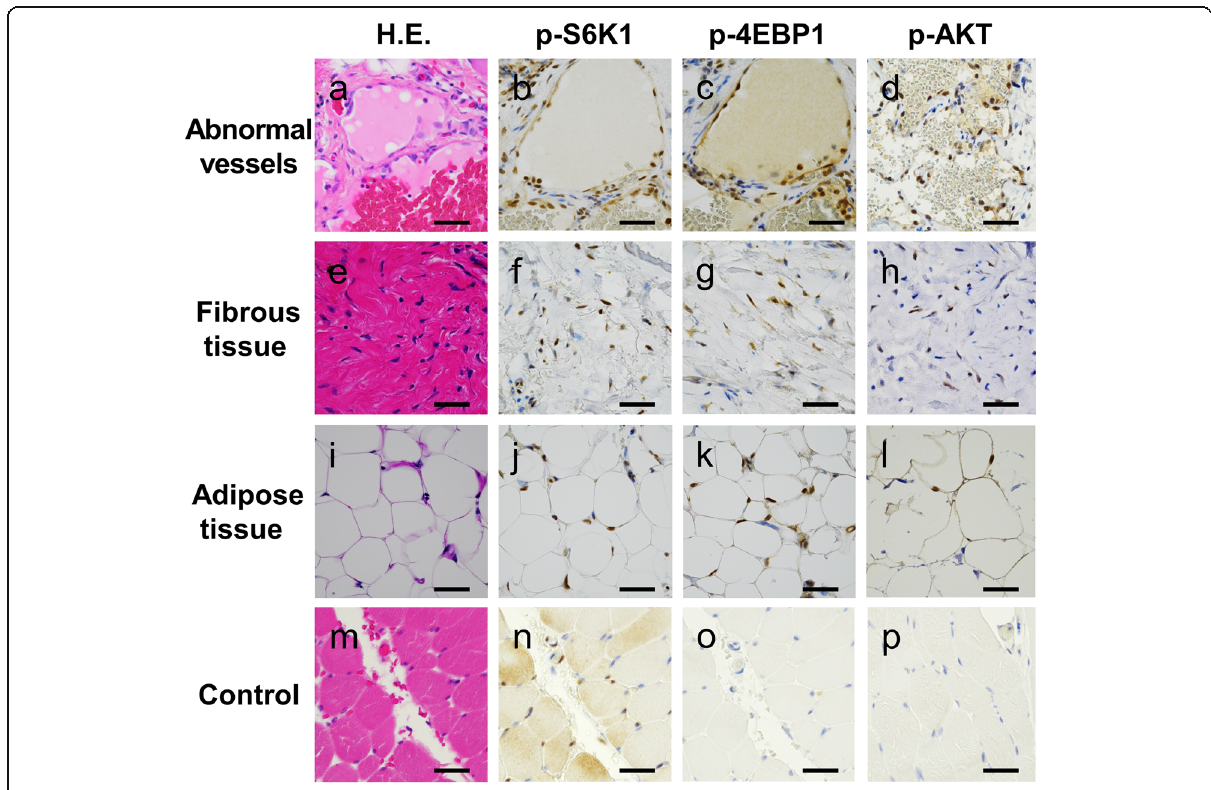
Fig. 3 Immunohistochemical analysis of mTOR pathway in various components of FAVA. Abnormal vessels ( a-d ), fibrous tissue ( e-h ) and adipose tissue ( i-l ) in FAVA. Control (normal connective tissues surrounding FAVA) ( m-p ). Staining for H&E ( a, e, i, m ), p-S6K1 ( b, f, j, n ), p-4EBP1 ( c, g, k, o ) and p-AKT ( d, h, l, p ). Scale bars: a-p = 50 μ